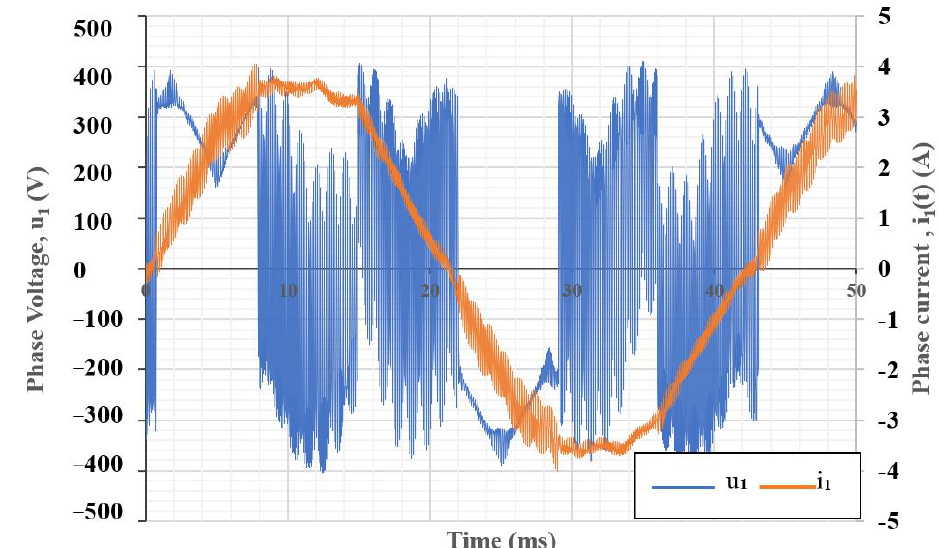
Figure 4. Phase voltage values and phase current values.